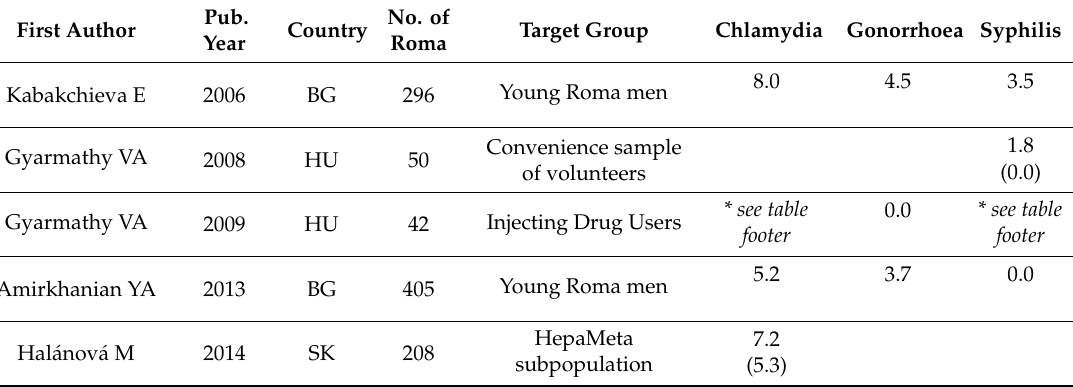
Table 4. Bacterial disease (per